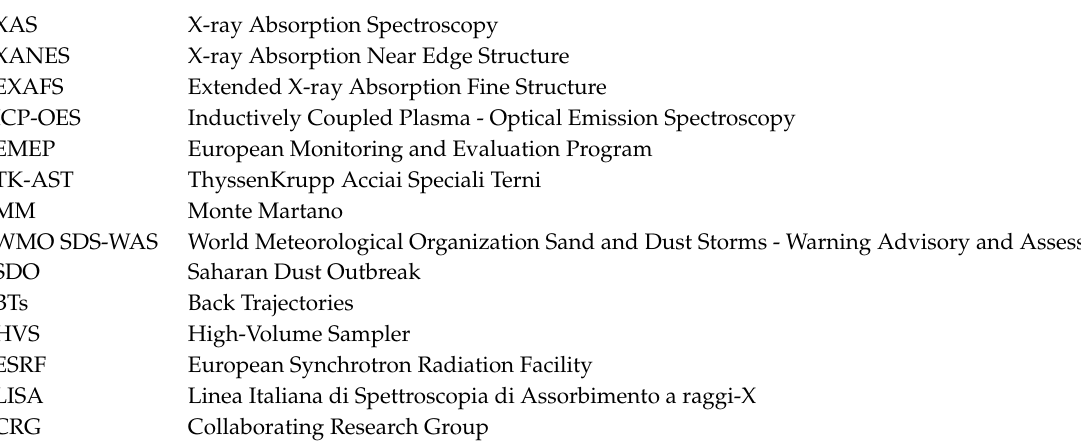
Figure S1: Sampling sites maps, Figure S2: Saharan dust advection, Figure S3: Self-absorption, Figure S4: AST_E45 sample comparison with model spinels, Table S1: Bond-Valence Method calculations, Figure S5: SEM-EDX analysis of the Saharan dust